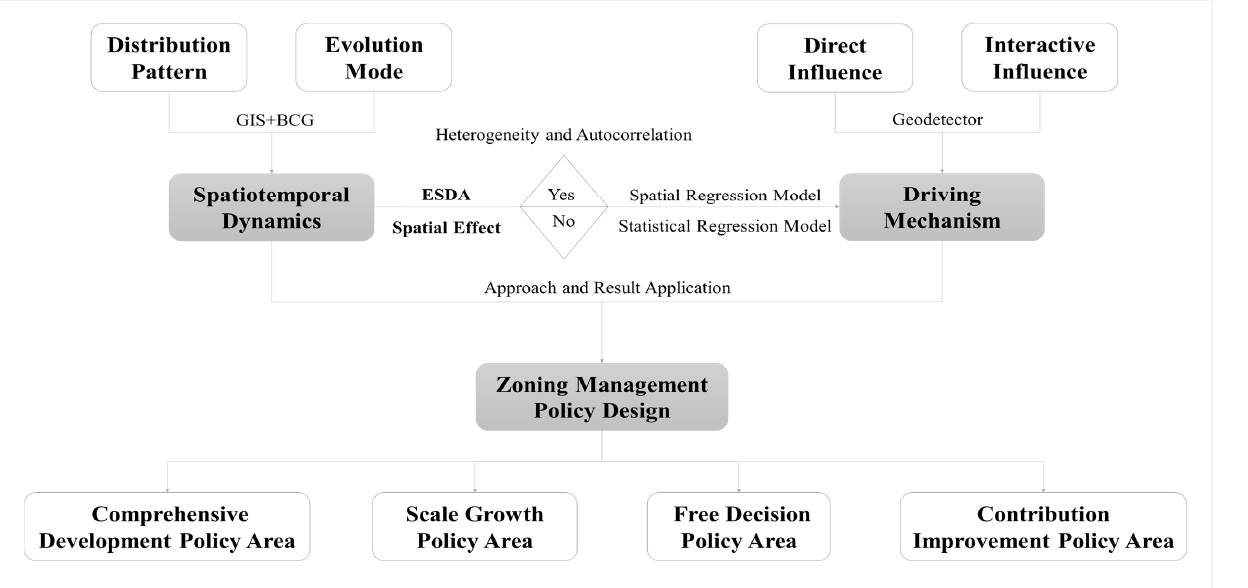
Figure 3. Comparative analysis of China’s real estate.